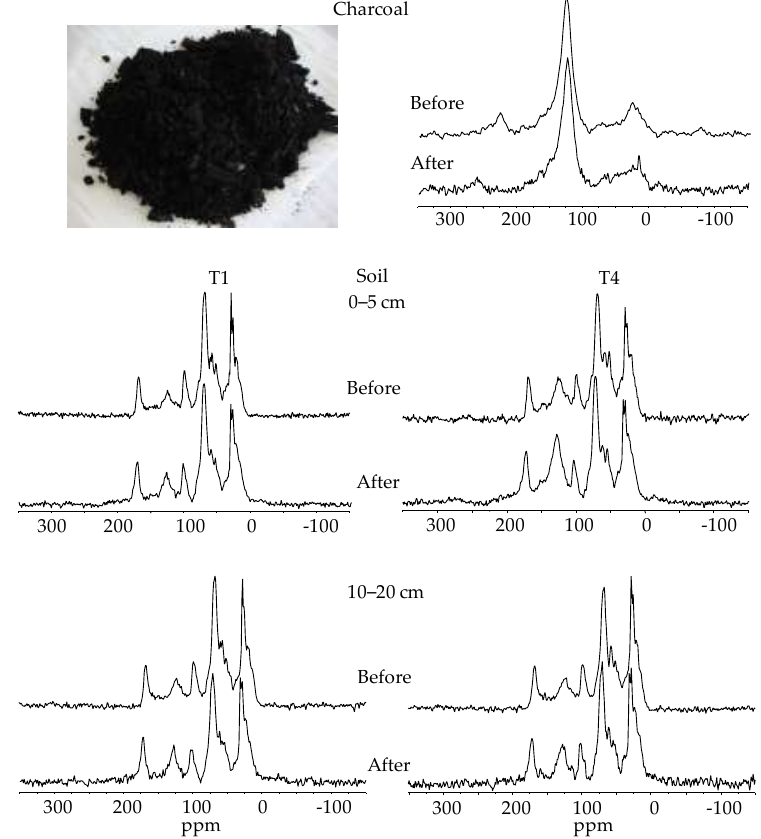
Figure 3. Charcoal illustration and Solid-state 13 C NMR spectra of the HCl-treated charcoal alone (not mixed with soil) and of HFtreated samples of a Cambisol without charcoal (T1) and with charcoal − 40 Mg ha − 1 (T4) application, before and after 165 incubation days, at 0–5 and 10–20 cm